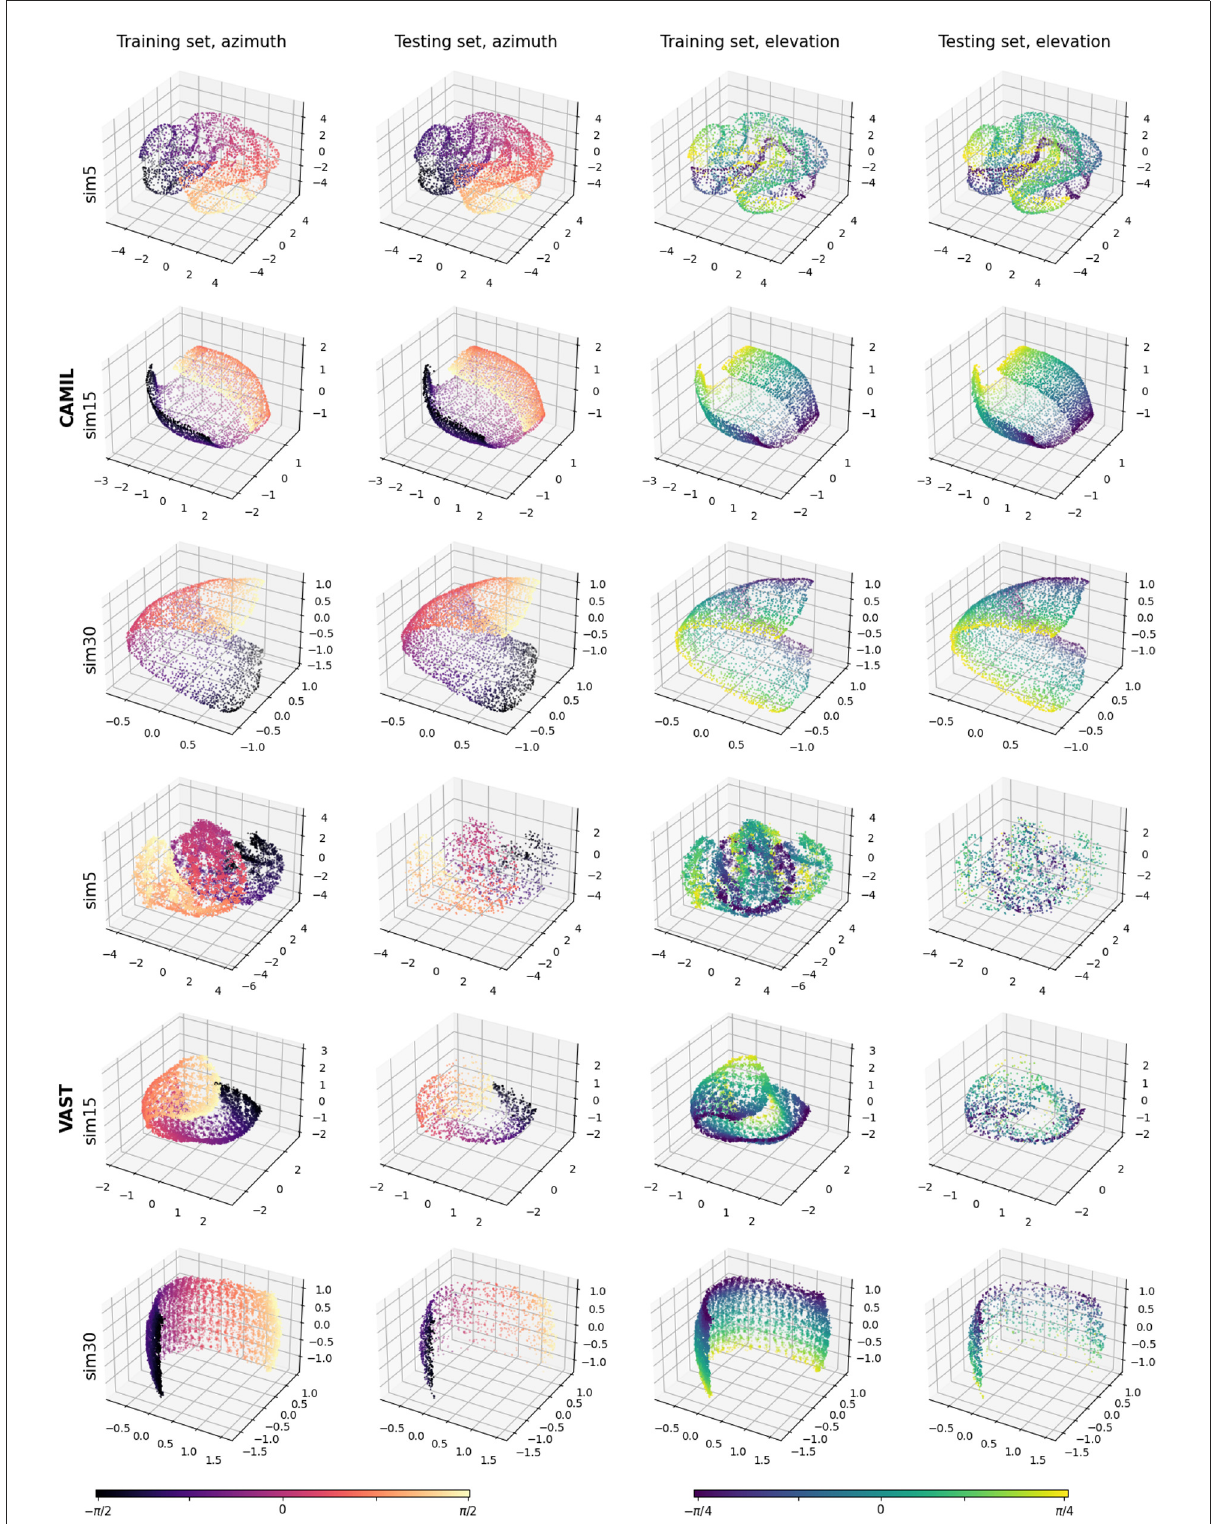
FIGURE5 Visualizations of the WSCE embeddings. Column 1 and 2 are azimuth training and testing embeddings. Column 3 and 4 are elevation training and testing